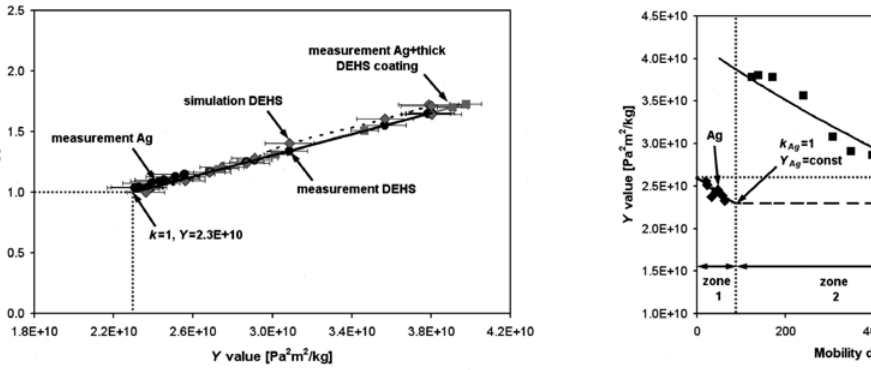
Fig. 8 The factor k as a function of the Y value. Fig. 9 Comparing the courses of trend lines from DEHS and silver mea-